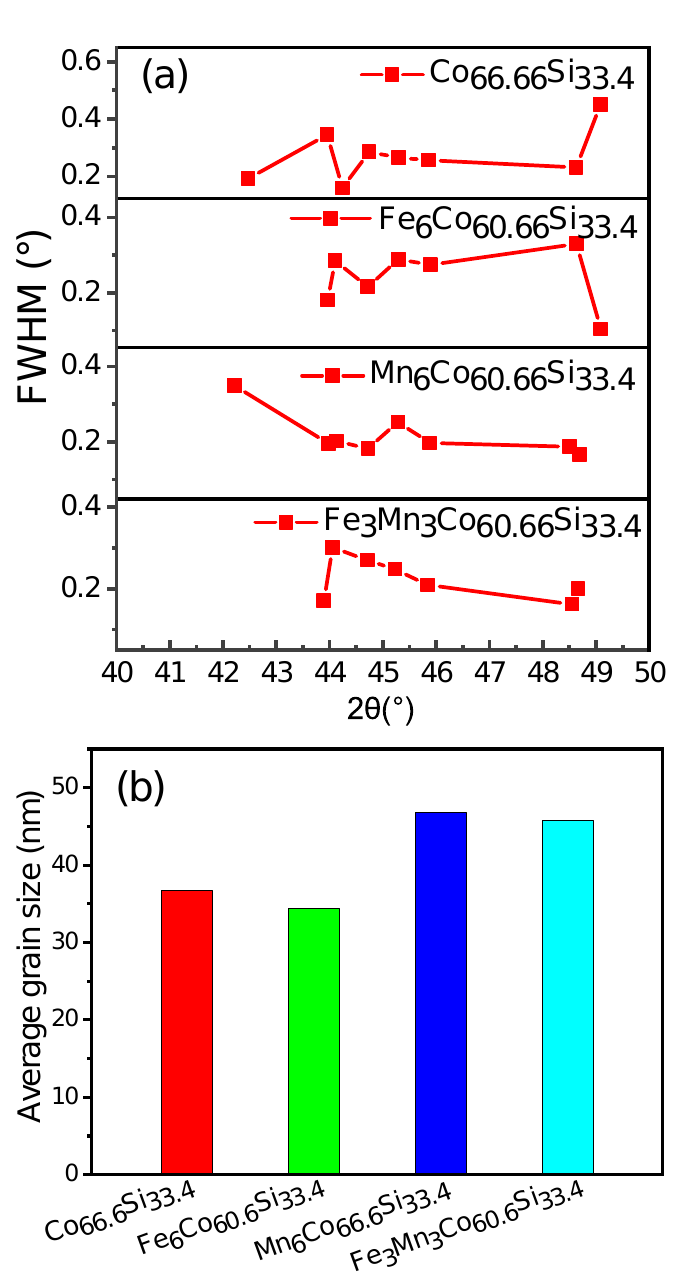
Figure 2. ( a ) FWHM of Co 66.6 Si 33.4 , Co 60.6 X 6 Si 33.4 , (X = Fe, Mn), and Co 60.6 Fe 3 Mn 3 Si 33.4 ; ( b ) Average grain size of as-prepared Co 66.6 Si 33.4 , Co 60.6 X 6 Si 33.4 , (X = Fe, Mn), and Co 60.6 Fe 3 Mn 3 Si 33.4 . A magnetic material affects the accuracy of the testing equipment, which is one of the reasons for the error. Figure 3a–d shows the powder micrograph images of Co 66.6 Si 33.4 , Co 60.6 X 6 Si 33.4 (X = Fe, Mn), and Co 60.6 Fe 3 Mn 3 Si 33.4 . The scale bar in Figure 3a–d equals 200 nm. The radii of Fe and Mn atoms are not greatly different from that of Co atoms. Hence, Fe and Mn atoms can enter the Co 2 Si lattice and replace the Co atoms. In the periodic table, Fe and Co are adjacent to each